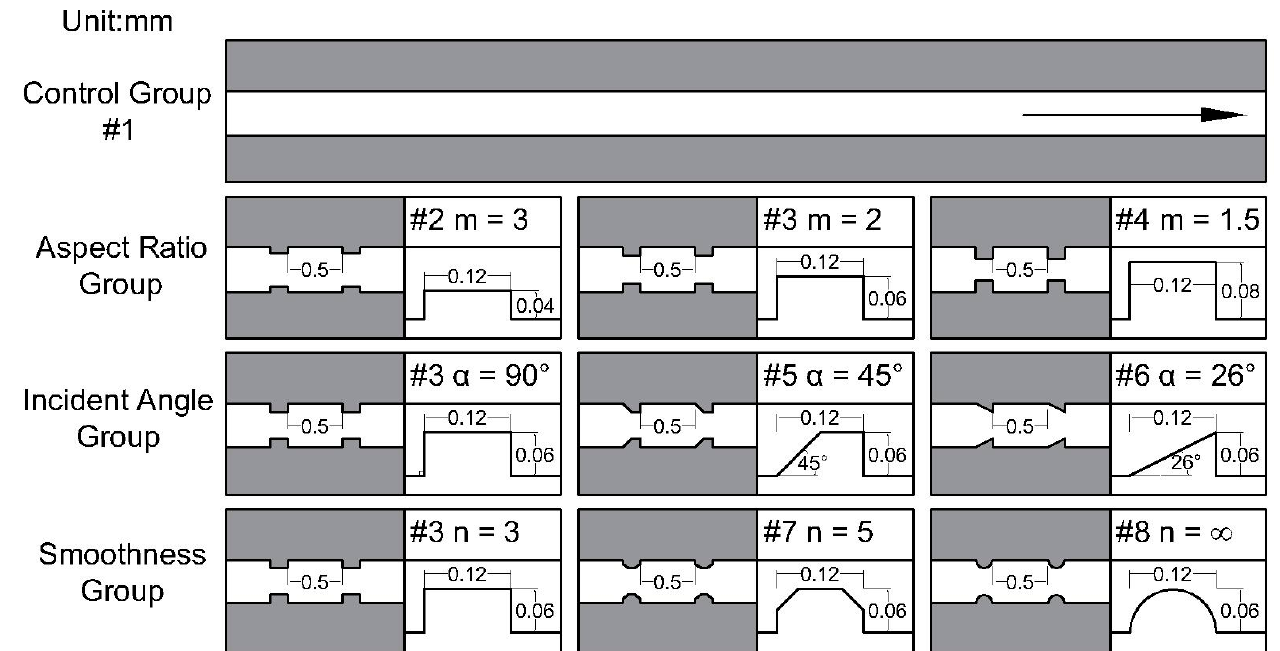
Figure 2. Schematic illustration of the microchannels and fins with different aspect ratios, incident angles, and smoothness values. Table 1. Geometrical parameters of the fins.